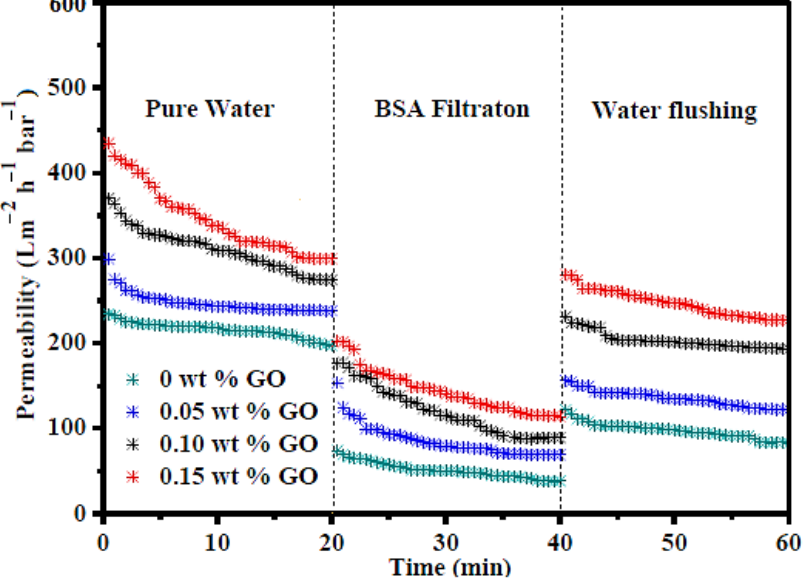
Figure 10. Permeation flux of fabricated PVC membranes incorporated with different amounts of GO before and after filtration of BSA solution [124]. PVC—poly (vinyl chloride); BSA—bovine serum albumin; GO—graphene oxide. Reproduced with permission from ref. [124]. Copyright 2016 Elsevier.